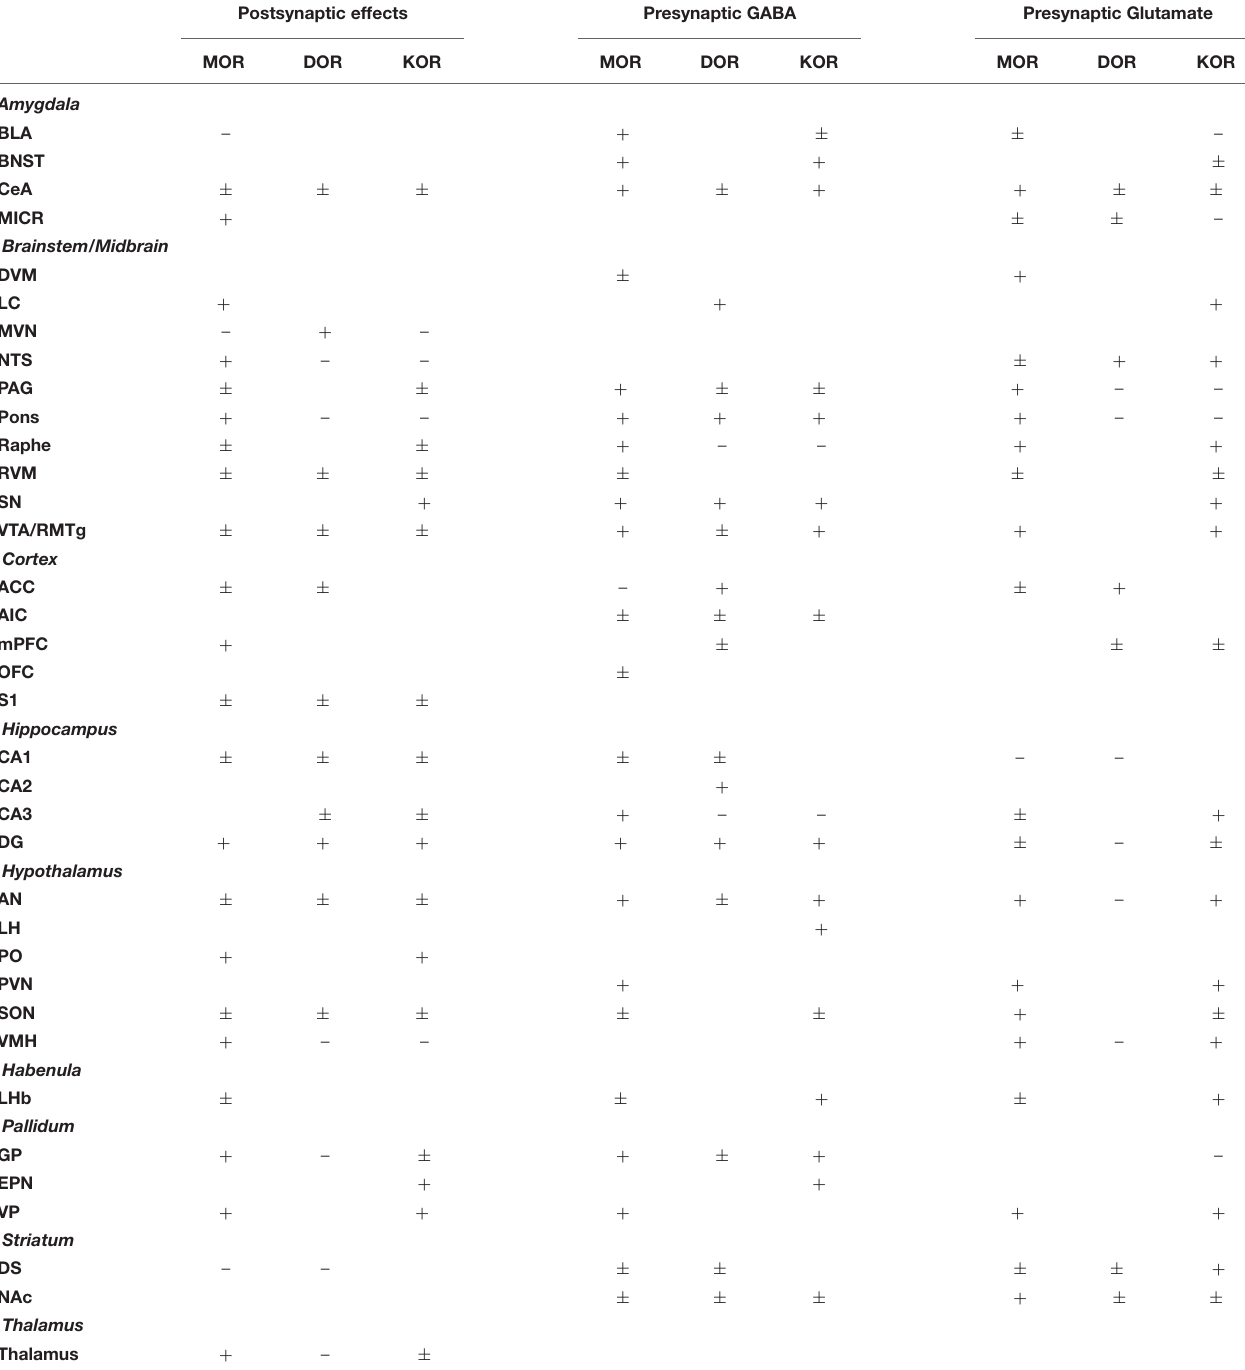
TABLE 1 | Summary of effects of mu (MOR), delta (DOR), and kappa (KOR) opioid receptor activation on neuronal excitability (postsynaptic effects), presynaptic GABA release, and presynaptic glutamate